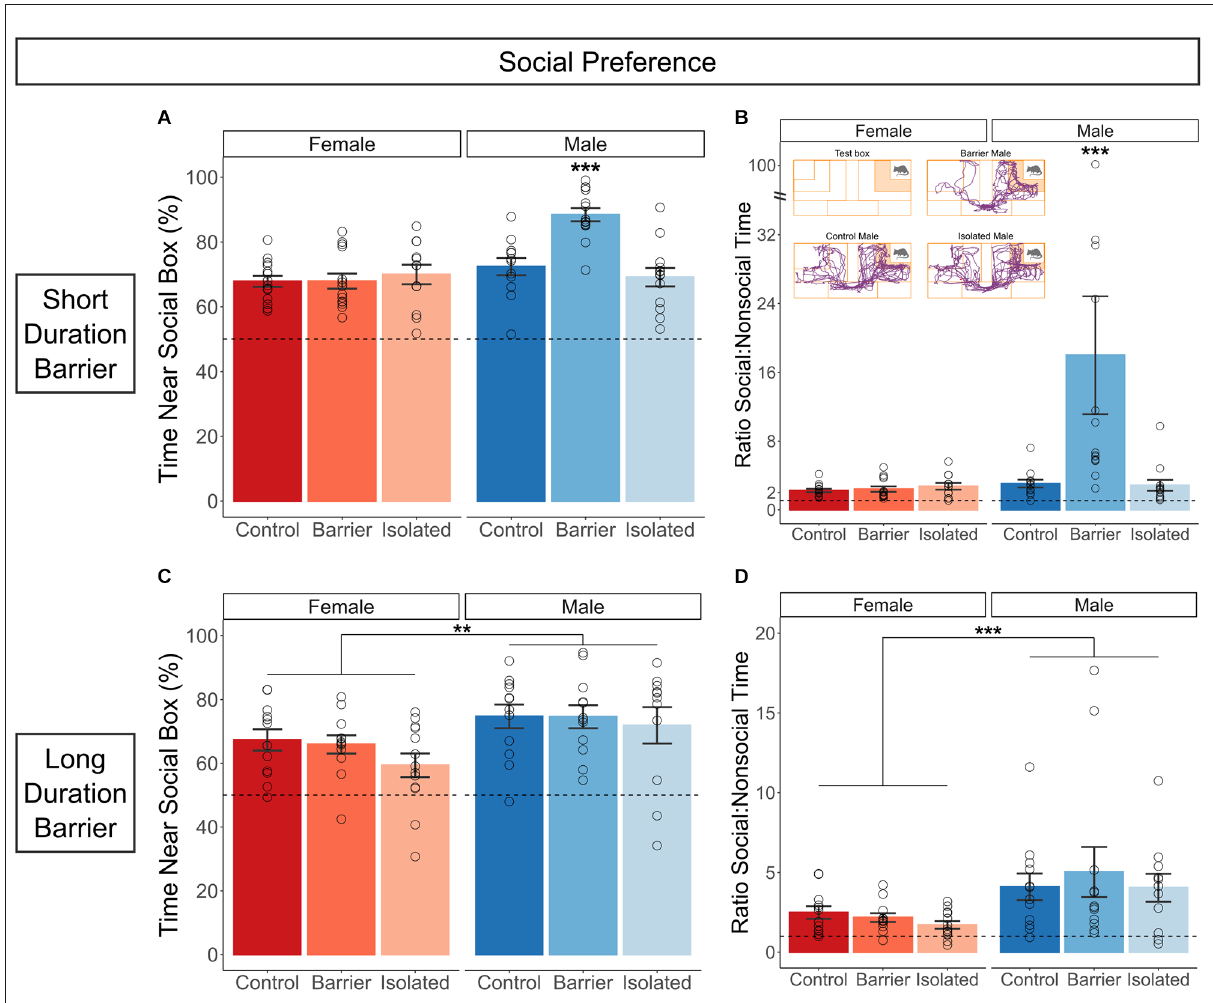
FIGURE6 Juvenile play deprivation, but not full social isolation, induces hypersociability in adult males in the short but not the long duration barrier study. Quantification of the percentage (A) and ratio (B) of time spent near the social stimulus box compared to time spent near the nonsocial, empty stimulus box in the short duration barrier experiment. In (A,B) , ***indicates male BARR animals significantly differed from all other groups on both measures, with p < 0.001. The inset in (B) shows representative traces from CTRL, BARR, and ISO males. The same measures are shown in (C,D) for the long duration barrier study. Bars indicate group means ± SEM, and open circles represent data from individual rats. ** p < 0.01, *** p < 0.001, n = 11–14 per